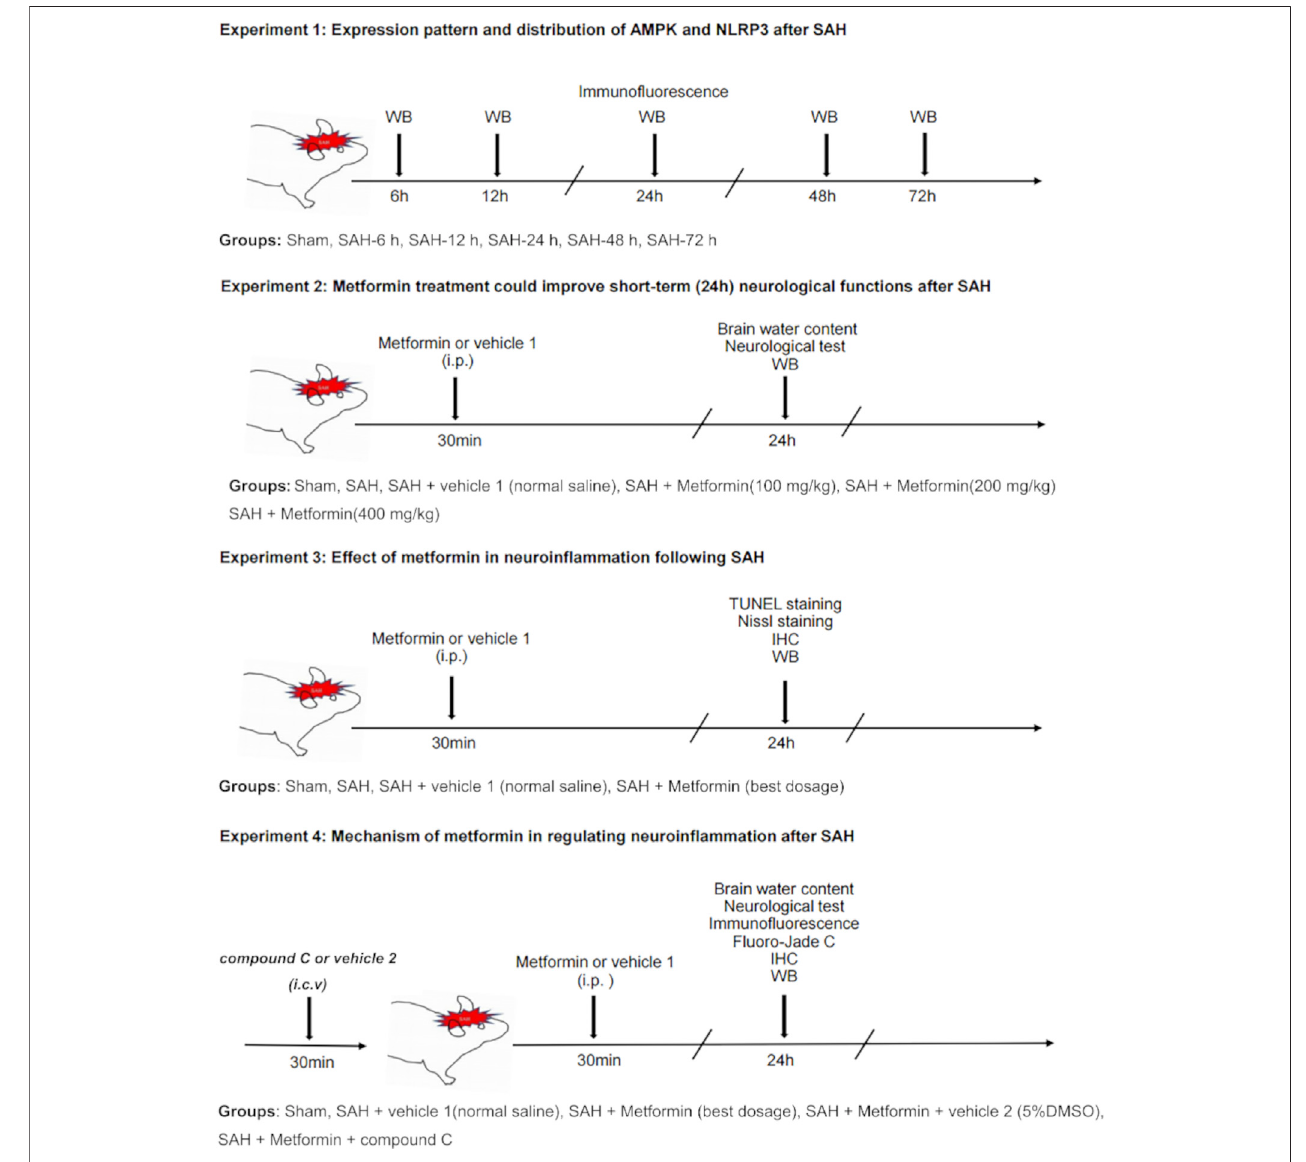
FIGURE 1 | Experimental design and animal groups. Abbreviation: AMPK, adenosine 5 ′ monophosphate-activated protein kinase; NLRP3, nucleotide-binding domain, leucine-rich containing family, pyrin domain-containing-3; SAH, subarachnoid hemorrhage; WB, western blot; IHC, immunohistochemistry; TUNEL, terminal deoxynucleotidyl transferase dUTP nick end labeling; i. p., intraperitoneal injection, i. c. v, intracerebroventricular injection.